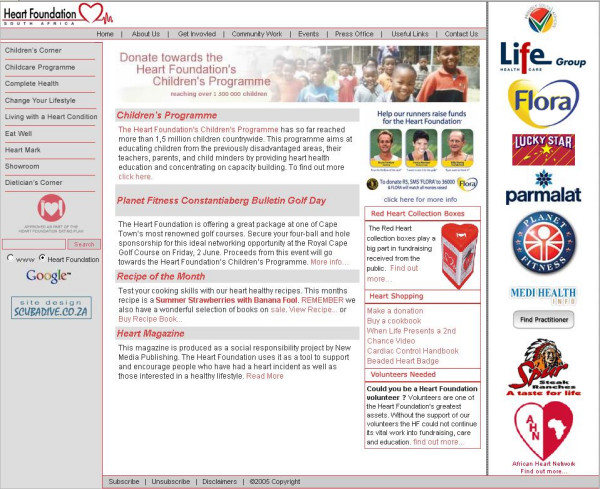
Screenshot of Heart Foundation of South Africa homepage with steakhouse sponsor logo.